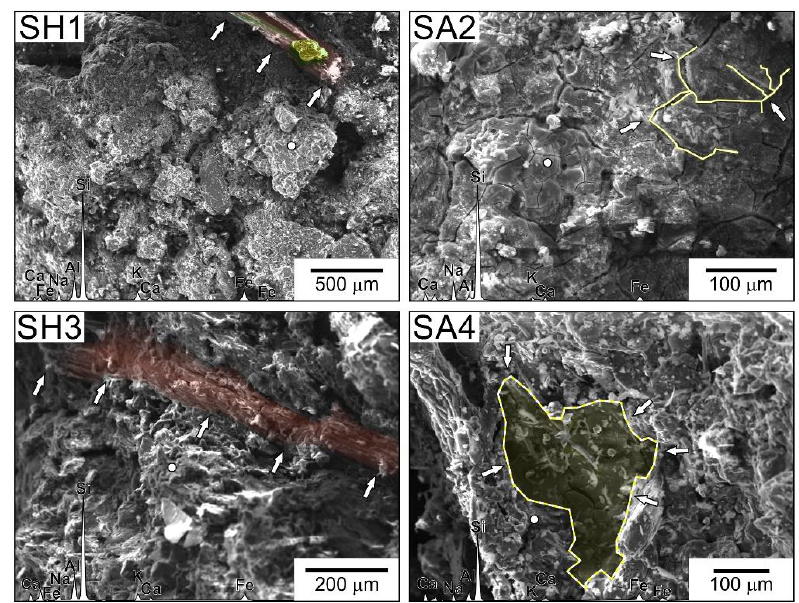
Figure 5. Scanning electron microscopy (SEM) images and EDX analyses.